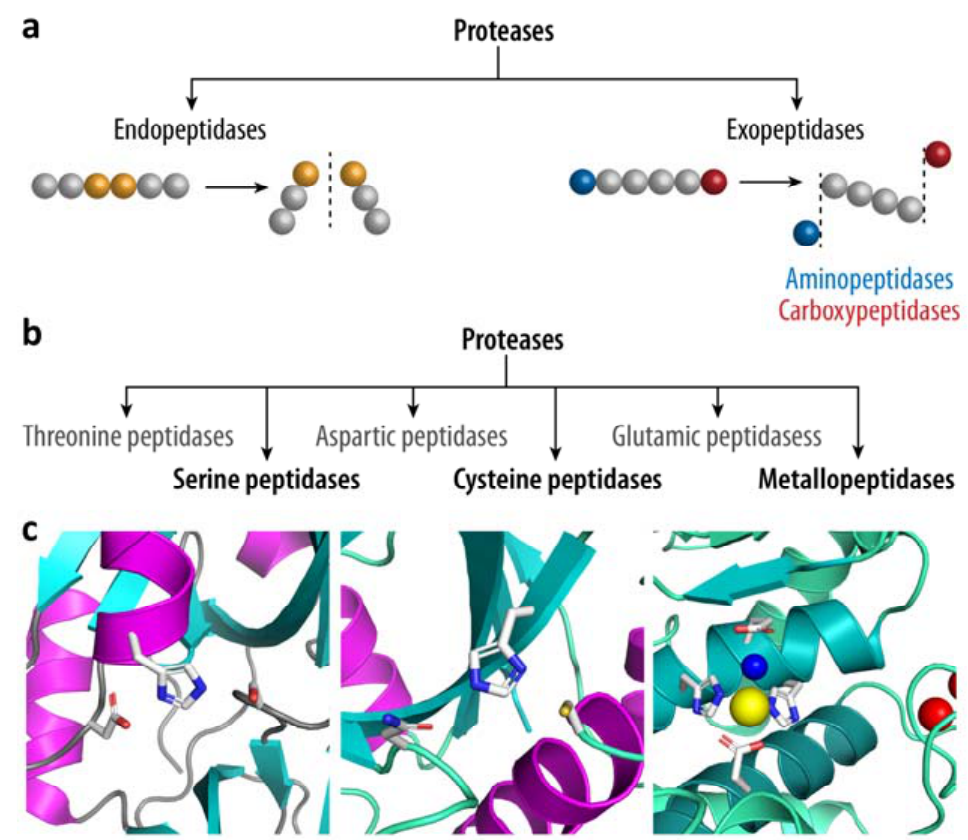
Figure 2. Classification of proteolytic enzymes. ( a ) Proteases can be classified by the site of substrate cleavage. While endopeptidases cleave within proteins, exopeptidases remove N- or C-terminal residues from the target protein. ( b ) Based on the active site responsible for cleavage of the scissile peptide bond, six classes of peptidases can be differentiated, of which threonine, serine and cysteine peptidases act through a covalent acyl-enzyme intermediate, while metallopeptidases and the acidic peptidases utilize an activated water molecule for the nucleophilic attack. ( c ) Active site views of three prominent proteases from Staphylococcus epidermidis are shown [40]. Left: the serine peptidase Esp (PDB entry 4jcn [41]), with a catalytic triad (from left to right) formed by Asp159/His117/Ser235. Middle: the cysteine peptidase EcpA with a Asn362/His341/Cys245 triad (based on a AlphaFold2 [42] model of UniProt ID Q5HKF6). Right: the gluzincin metallopeptidase SepA, with His355, Glu375, and His351 as the proteinaceous zinc-binding ligands, and Glu352 as the general base (HE 352 xxH(x) 19 E). The catalytic zinc ion is highlighted in yellow, while two structural calcium ions are shown in red. The depicted SepA active site is based on a AlphaFold2 [42] model of UniProt ID P0C0Q4, while the metal ions and the active site water were inferred from PDB entry 1bqb [43]. All molecular graphics representation were created using an open-source build of PyMOL version 2.5 (The PyMOL Molecular Graphics System, Schrödinger, LLC, New York, NY, USA)